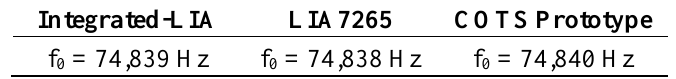
Table 5. Fundamental frequency measurement using different LIA